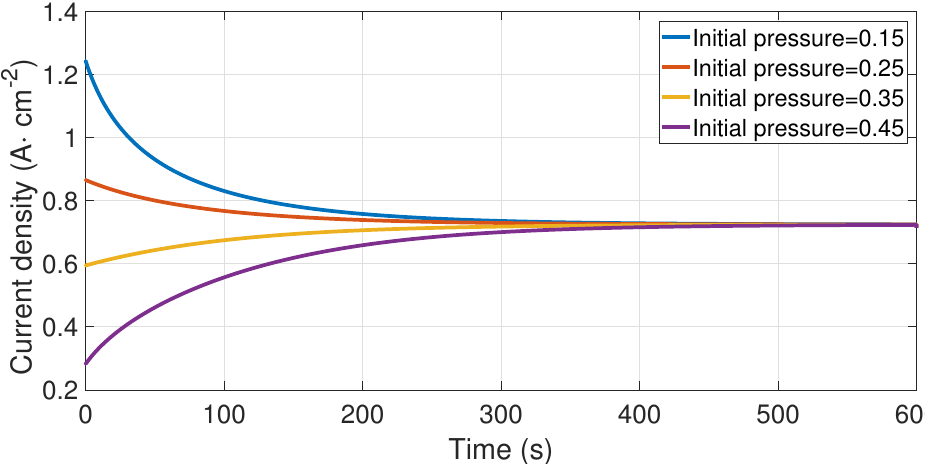
Figure 5. Simulation of electrical current density stability with different values θ 0 .